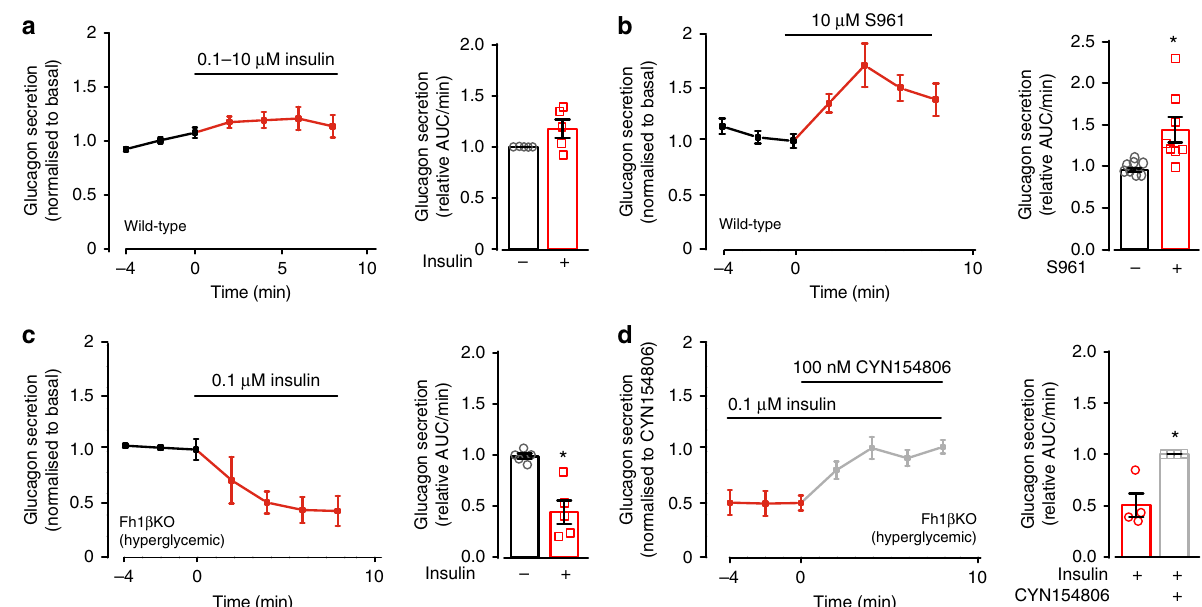
Fig. 6 Effects of insulin in the perfused mouse pancreas. a Glucagon secretion measured before and after addition of insulin using the perfused mouse pancreas preparation. For these experiments, wild-type mice were used. In each experiment, glucagon secretion was normalised to that at 4 mM glucose prior to the addition of insulin (100 nM in three experiments and 10 μ M in two experiments: responses have been pooled for display; female mice were used). b As in a but the insulin receptor antagonist S961 was used instead of insulin ( n = 7 female mice). c As in a but experiments were performed in hyperglycaemic/diabetic Fh1 β KO mice and using insulin at a concentration of 100 nM ( n = 8 mice of both sexes). In a - c , the black bars represent mean glucagon secretion measured during the 6 min preceding the addition of insulin or S961. d As in ( c ) but CYN154806 was included as indicated ( n = 4 diabetic Fh1 β KO mice of both sexes). Glucagon secretion has been normalised to that in the presence of CYN154806 (measured at steady-state, 4 – 8 min after the addition; t = 4 – 8 min). The red and bars represent glucagon secretion in the presence of insulin alone and following the addition of CYN154806, respectively. Statistical signi fi cances were analysed by Student ’ s t -test. * p < 0.05. Data are presented as dot plots of individual experiments and/or